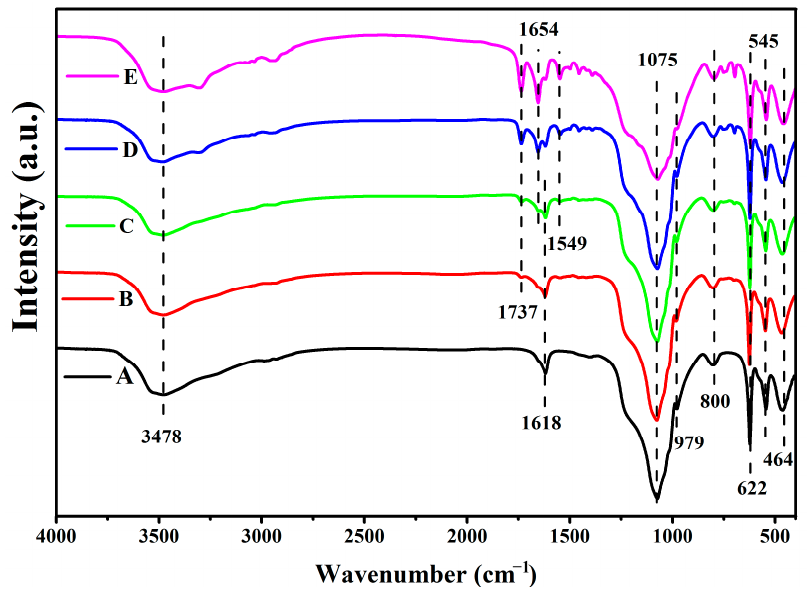
Figure 5. FT-IR spectra of GdPO 4 ·H 2 O@SiO 2 (A) and the modified products synthesized with different proportions of GdPO 4 ·H 2 O@SiO 2 –APS:NCA = 1:0.125 (B), 1:0.25 (C), 1:0.5 (D) and 1:1 (E).